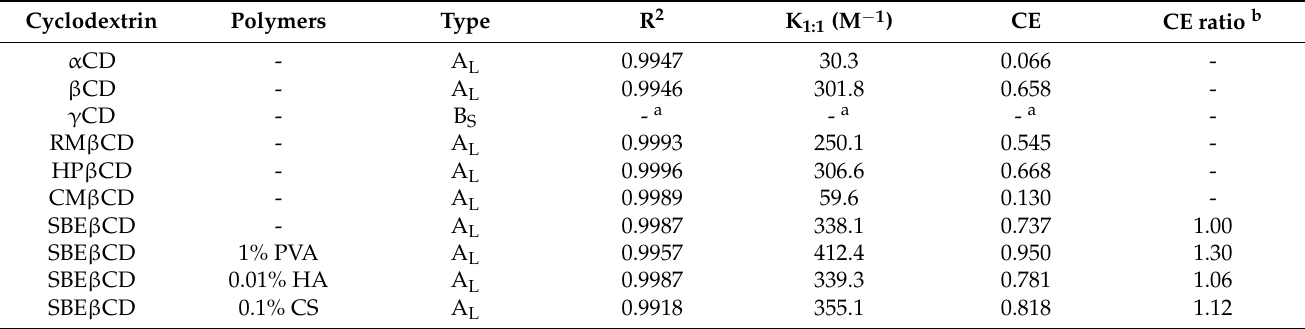
Table 2. Apparent stability constants (K 1:1 ) and the complexation efficiency (CE) values of VCZ/CD complexes in aqueous solutions with and without individual polymers at 30 ◦ C ± 1 ◦ C (mean, n =